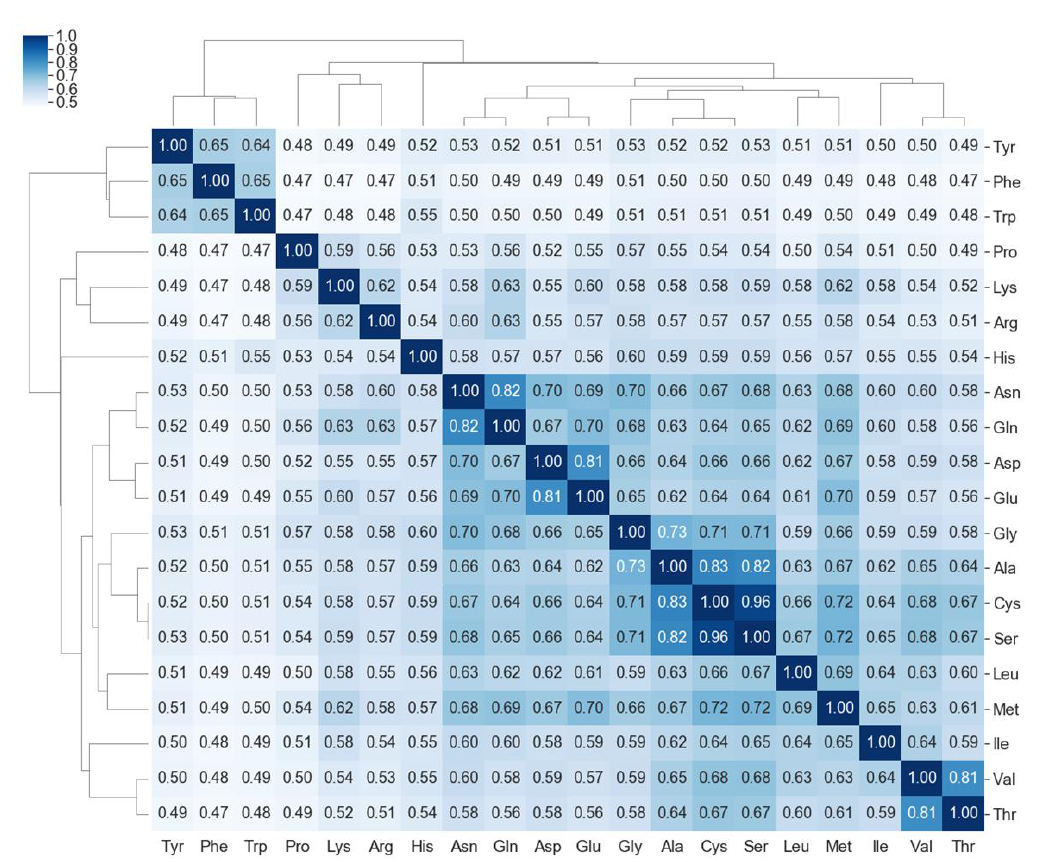
Figure 4. Clustered similarity matrix of MTMs of 20 amino acids.